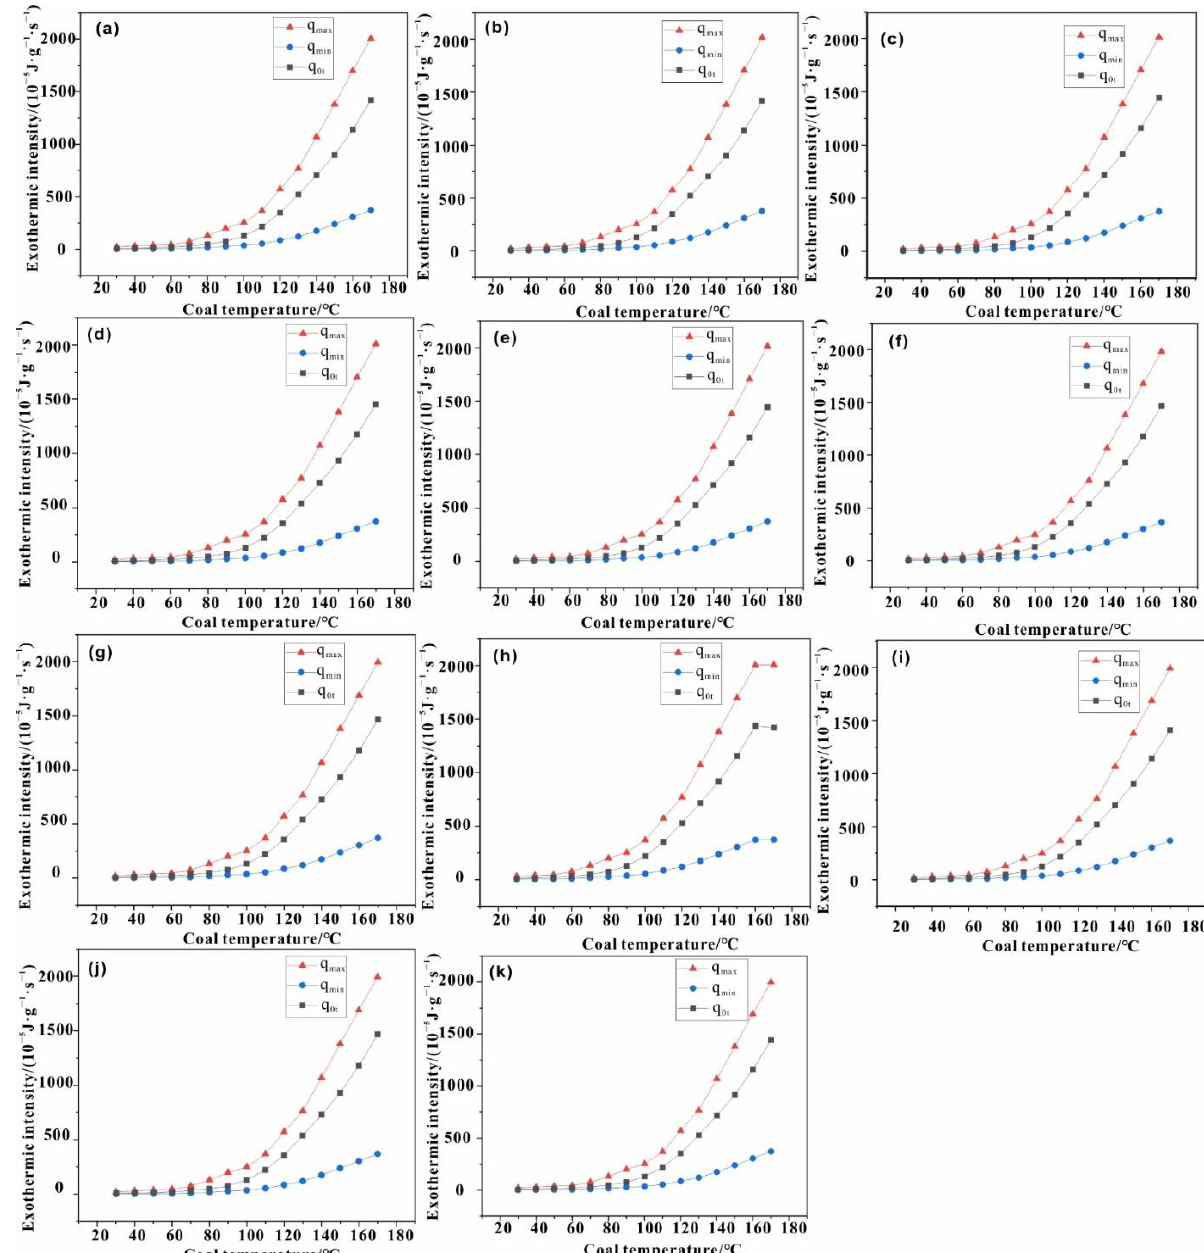
Figure 6. Curve of heat release intensity of PS. ( a – k ) represent different leading temperatures.